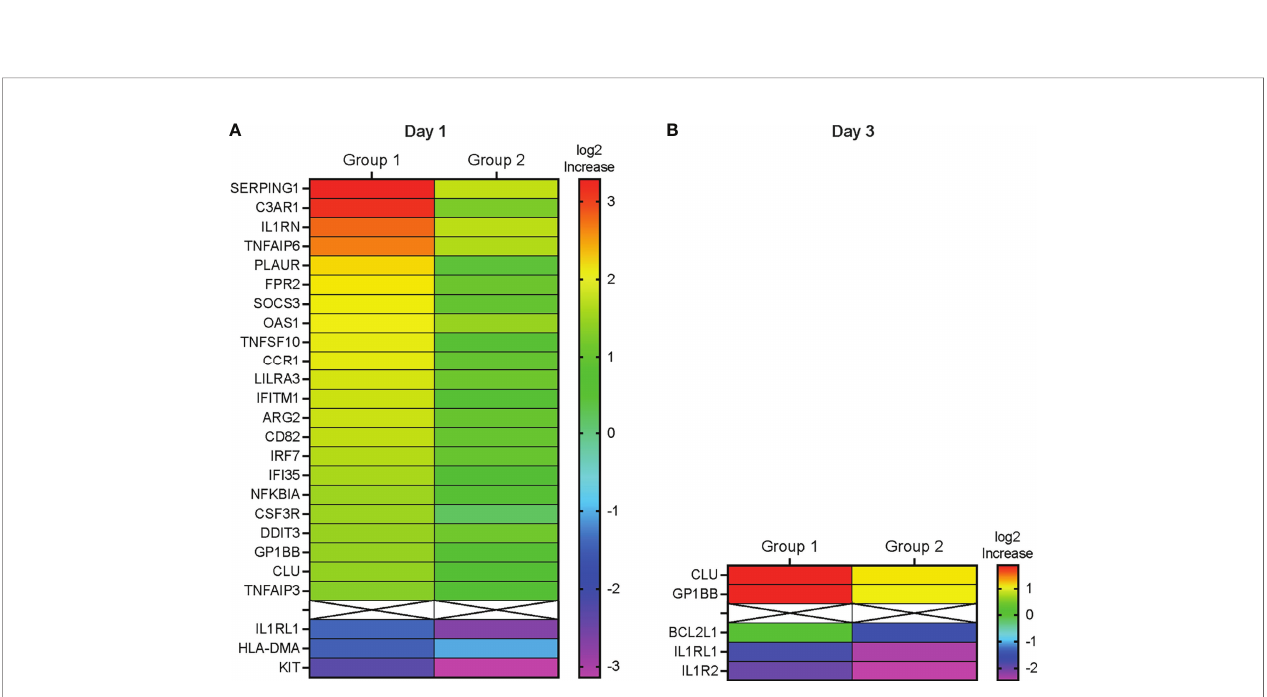
FIGURE 5 | Differentially expressed genes. (A, B) Heatmap depicting the log 2 fold-increase (FI) of differentially expressed genes at D1 compared to D0 (A) or at D3 compared to D0 (B) with an adjusted p ≤ 0.1. DEG are ordered from top to bottom according the highest (red) to the lowest (purple) fold-increase (FI) in log2 gene expression in Group 1 as indicated by the color legend bar. The corresponding Group 2 log 2 gene expression values are also shown.